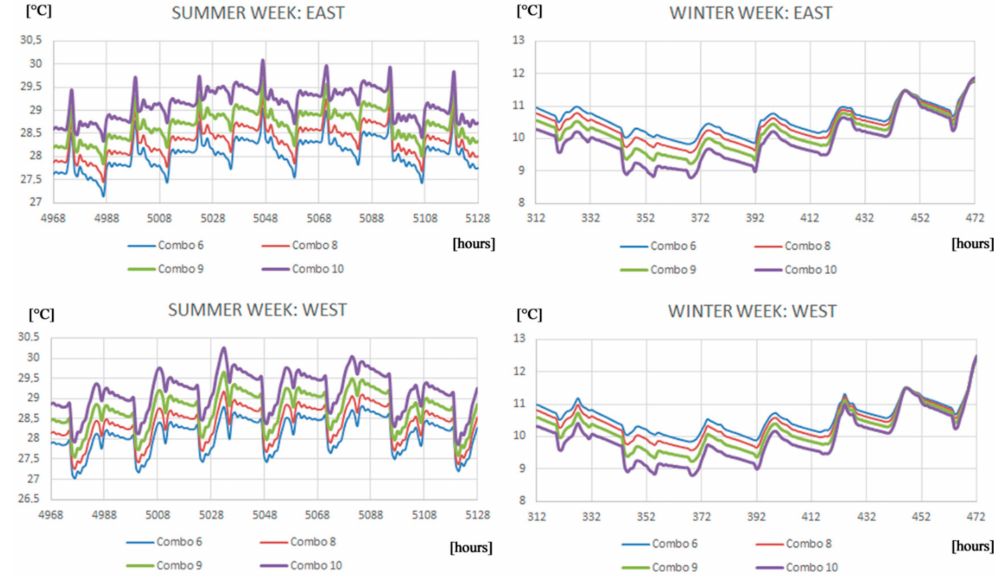
Figure 13. TOP trend for Combos 6, 8, 9, and 10 (27 July–2 August; 14 January–20 January).